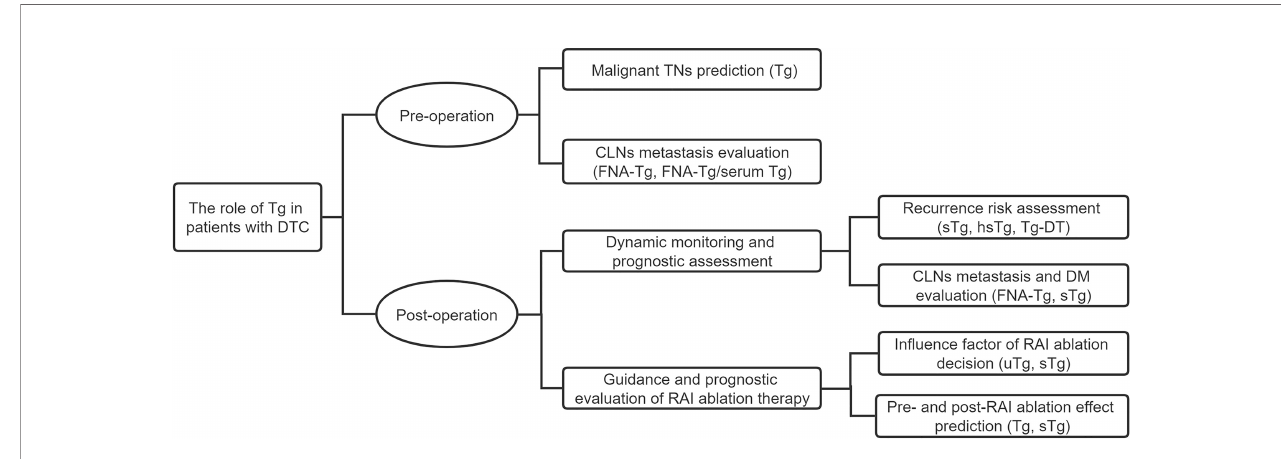
FIGURE 2 | Outline of the role of thyroglobulin in patients with differentiated thyroid